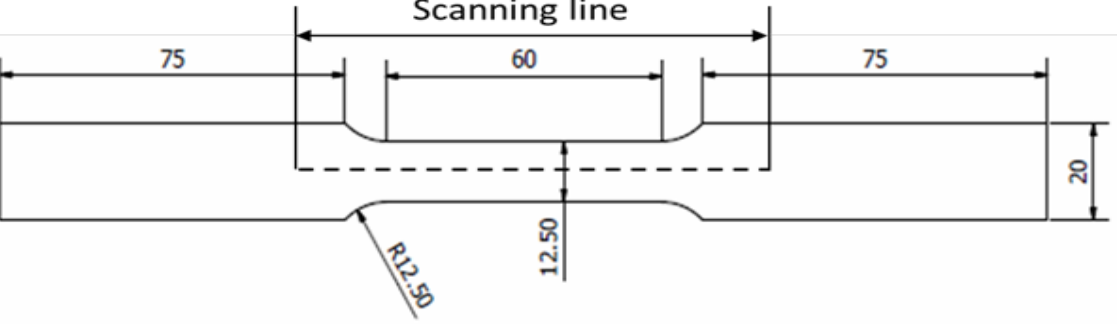
Figure 4. API X65 specimen geometry with scanning line (unit in mm).